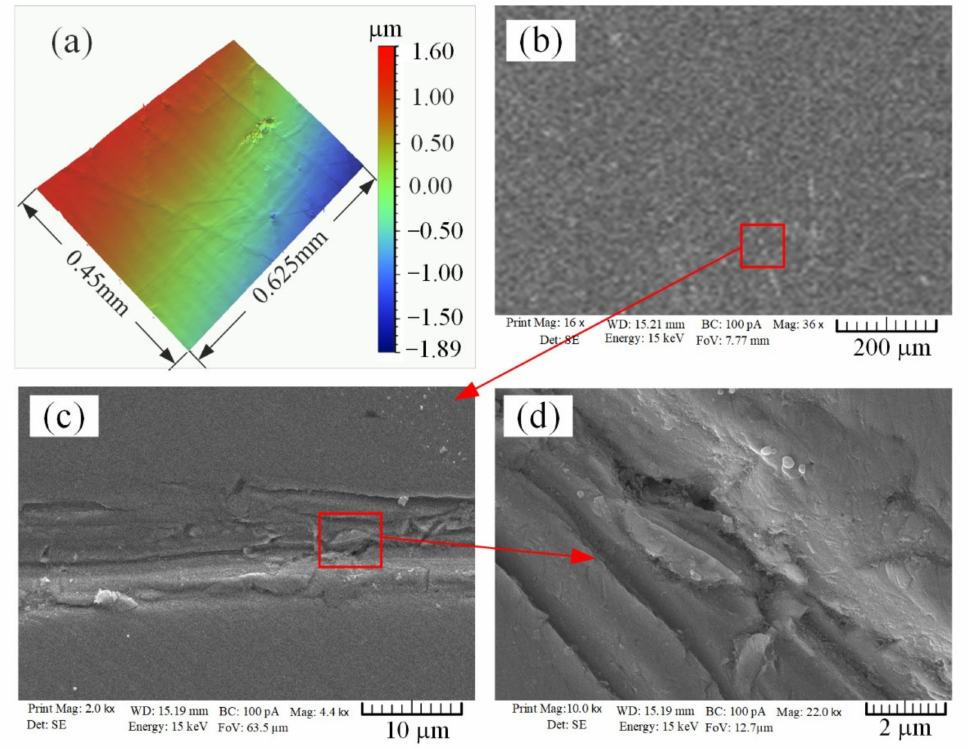
Figure 4. Three-dimensional surface topography ( a ) and SEM micrographs of the polished sample and its enlarged appearance ( b – d ).